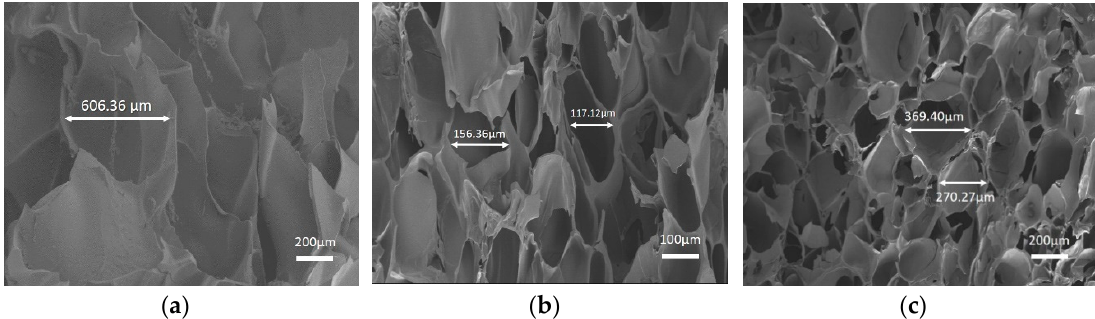
Figure 8. SEM images of freeze-dried hydrogels with different compositions. ( a ) OSA-DTP hydrogel; ( b ) CMC-OSA-DTP hydrogel; ( c ) CMC-OSA hydrogel.